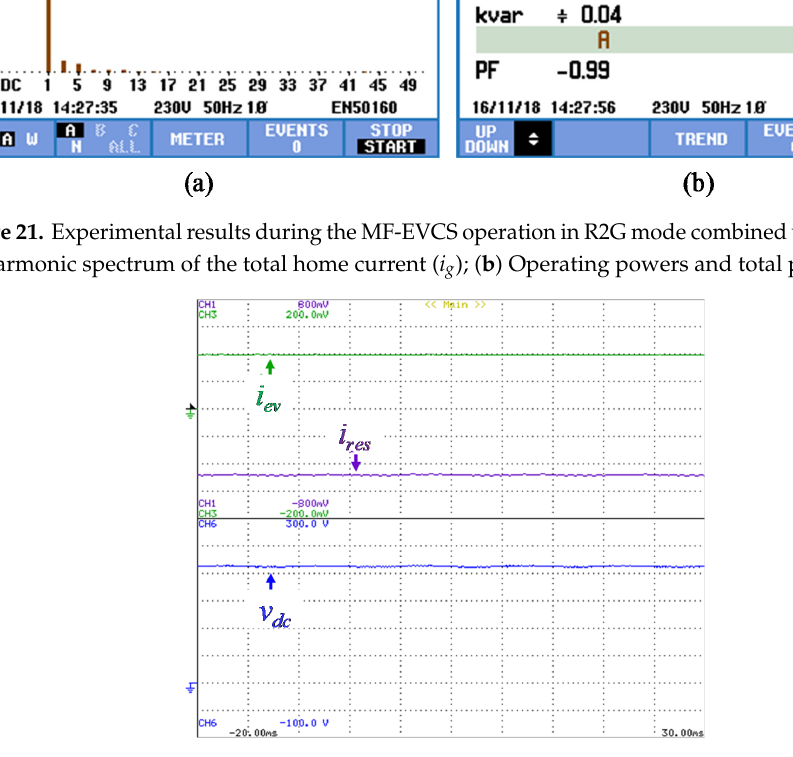
Figure 22. Experimental results during the MF-EVCS operation in R2G mode combined with R2V mode: Current in the EV battery ( i ev : 0.5 A/div); Current in the RES interface ( i res : 2 A/div); Dc-link voltage ( v dc : 50 V/div).